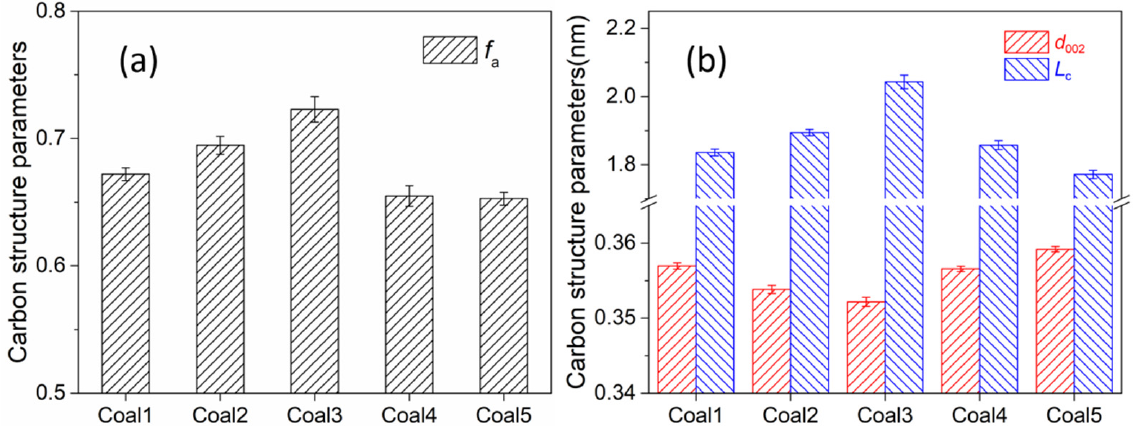
Figure 3. Structural parameters obtained from the curve-fitting of XRD spectra: ( a ) f a and ( b ) d 002 and L c .